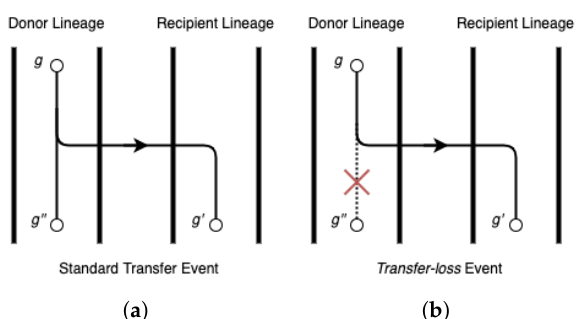
Figure 1. Illustration of the difference between ( a ) a standard transfer event and ( b ) a TL event. Definition 2 (Transfer from unsampled lineage ( TX )) . A transfer from unsampled lineage ( TX ) event occurs when the donor species is not represented in the species